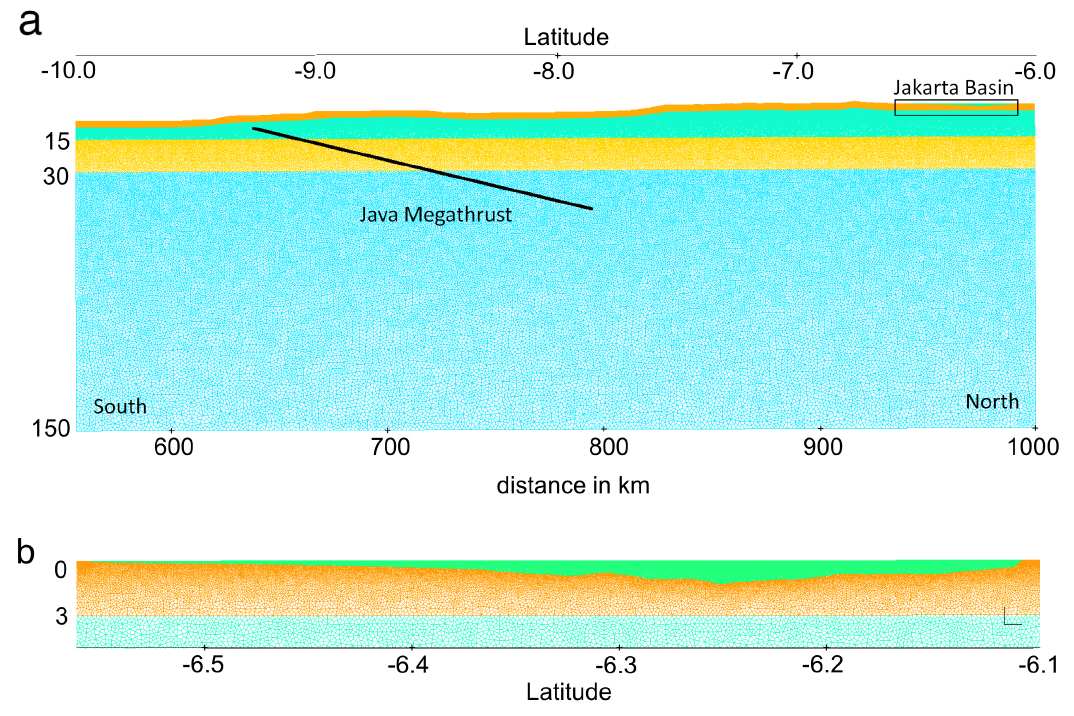
Figure 6. ( a ) The SPECFEM2D computational domain consists of a 5-layered medium, with the surface topography extracted from SRTM and the basin geometry resulting from the HVSR inversion. The vertical axis is depth (km) and horizontal is latitude in km and degree. The thick black line represents an inclined set of 1002 point sources along the subduction zone megathrust, and the area of the rectangle basin inset shown in ( b ) is indicated. For the crustal fault and deep intraslab scenarios, different dimensions of domain areas are used but the mesh-sizes for the first 4 top layers are the